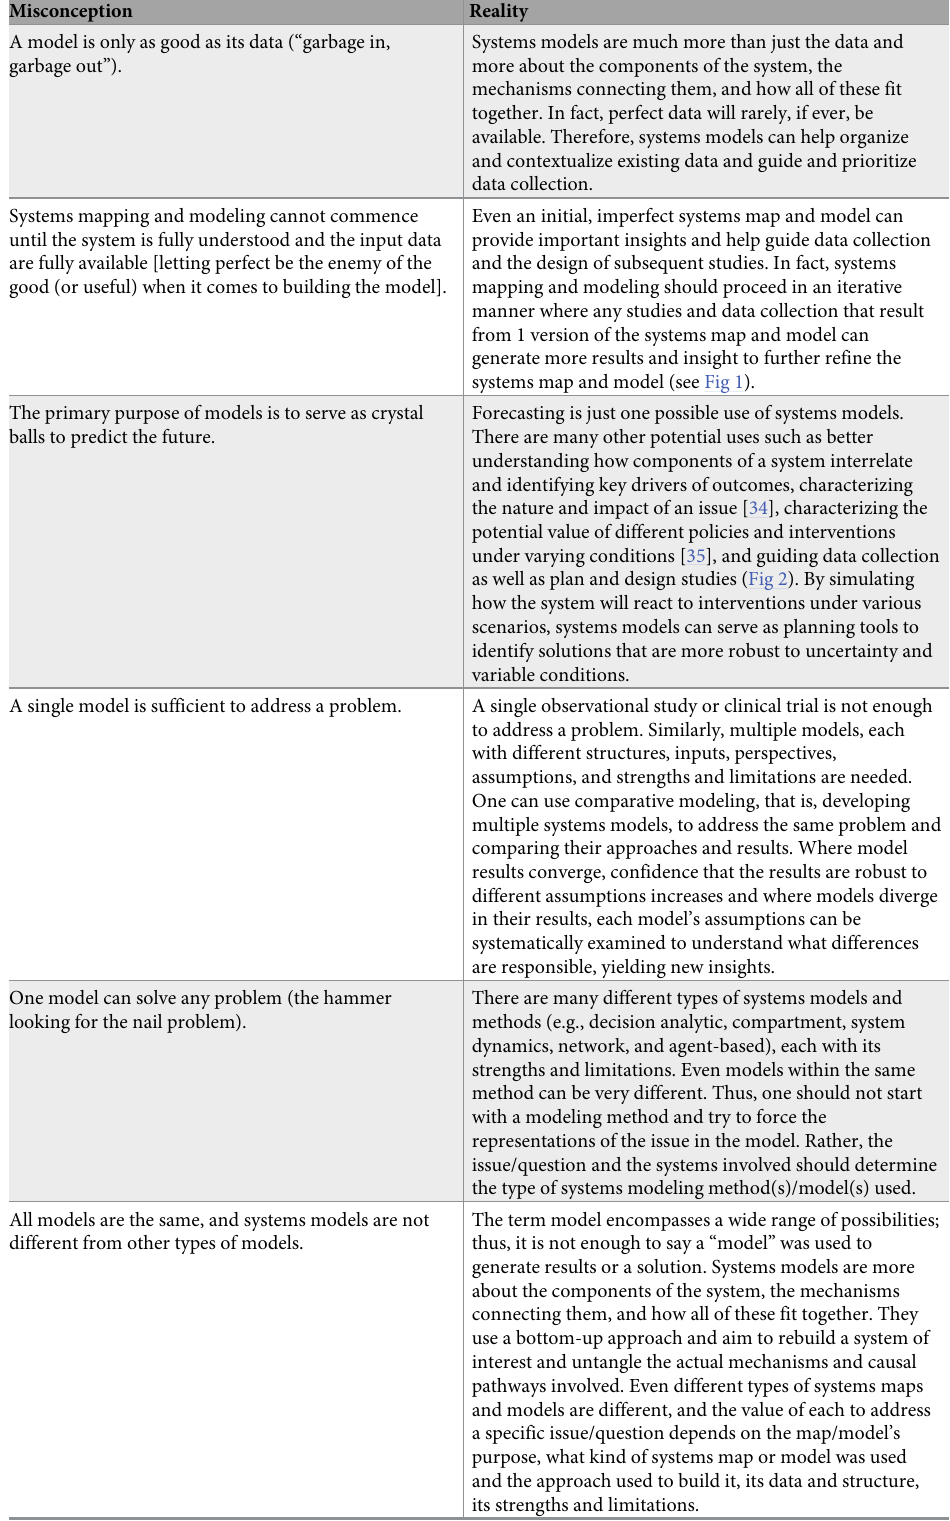
Table 1. Common misconceptions about systems maps and